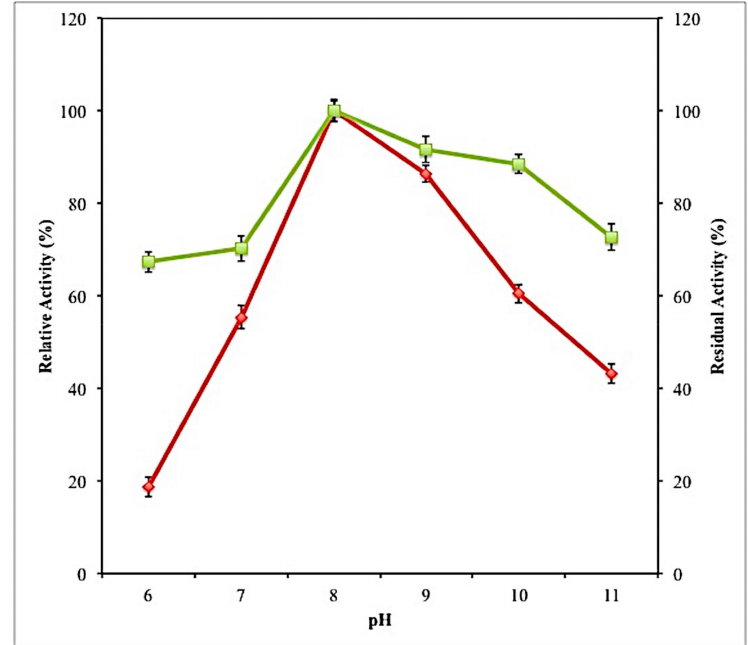
Figure 6. Effect of pH on the activity ( (cid:7) ) and stability ( (cid:4) ) on purified lipase. Enzyme activity was determined by assaying its activity on various pH values. Enzyme stability was investigated by incubating the enzyme at different pH values (6.0–11.0) for 1 h at 37 ◦ C. All the assays were conducted in triplicate and the average values were taken.